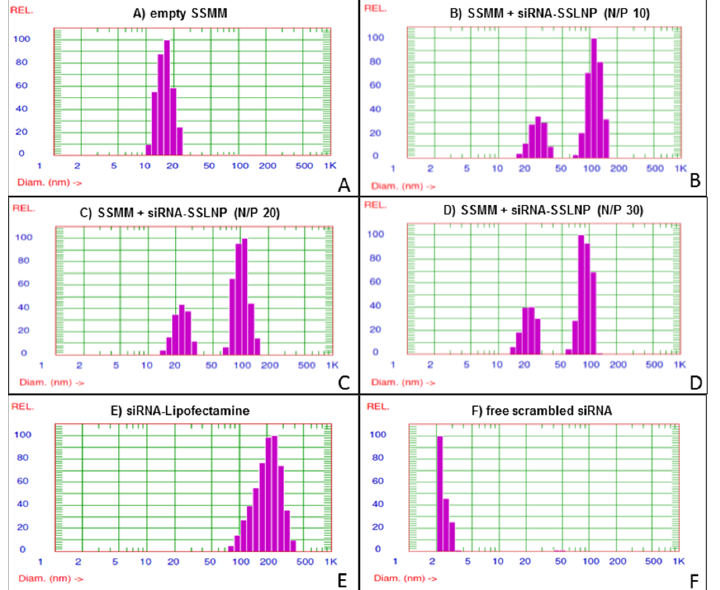
Figure 1. small interfering RNA in sterically stabilized phospholipid nanoparticles (siRNA-SSLNP) optimization in vitro : Representative particle size distribution of ( A ) Unimodal size distribution of empty SSMM (sterically stabilized mixed micelles); ( B ) Empty SSMM and siRNA-SSLNP with N/P ratio of 10; ( C ) Empty SSMM and siRNA-SSLNP with N/P ratio of 20; ( D ) Empty SSMM and siRNA-SSLNP with N/P ratio of 30; ( E ) siRNA lipofectamine (siRNA-Lipofectamine) complex; ( F ) Free siRNA molecules.